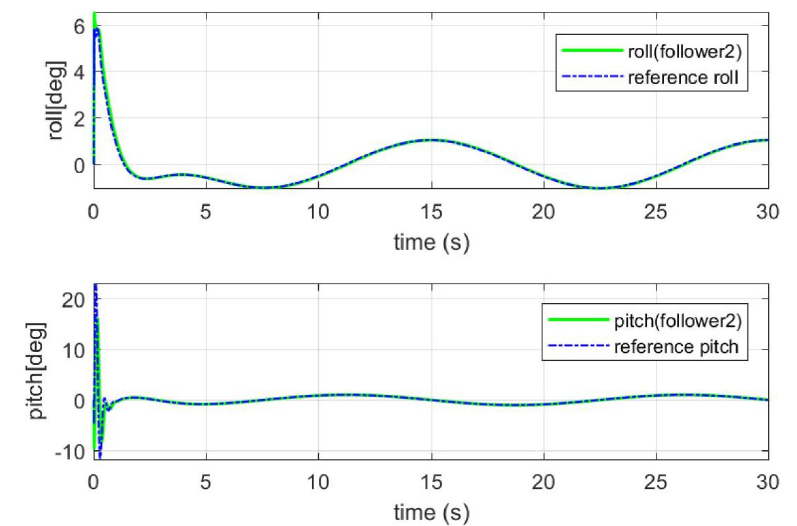
Figure 7. The reference angles of the second follower quadrotor for the proposed formation control: the meanings of the dashed line and the solid line are the same as in Figure